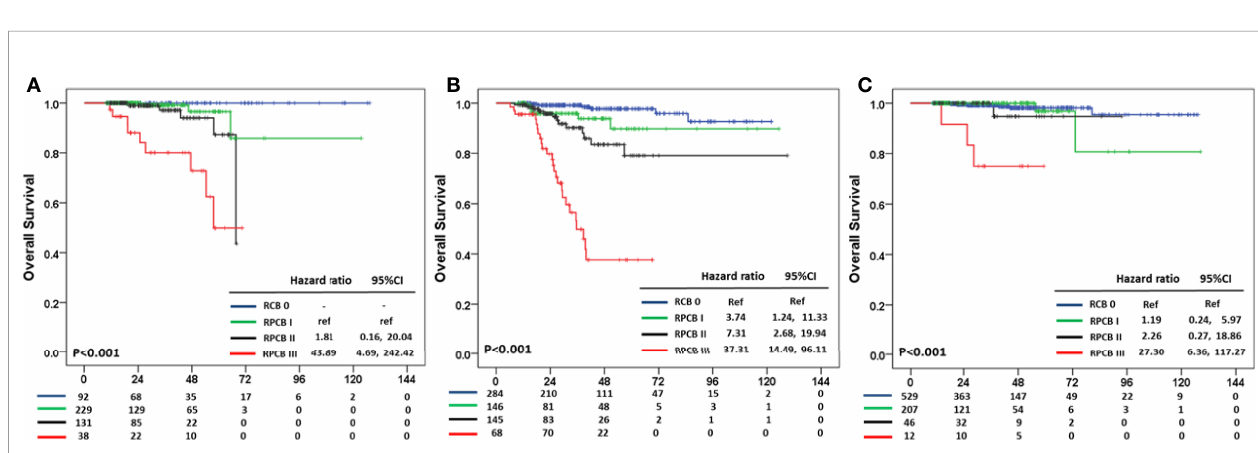
FIGURE 3 | Residual Proliferative Cancer Burden prediction model according to BC subtypes in DFS (A) HR+HER2 − subtype (B) TNBC subtype (C) HER2+ subtype.